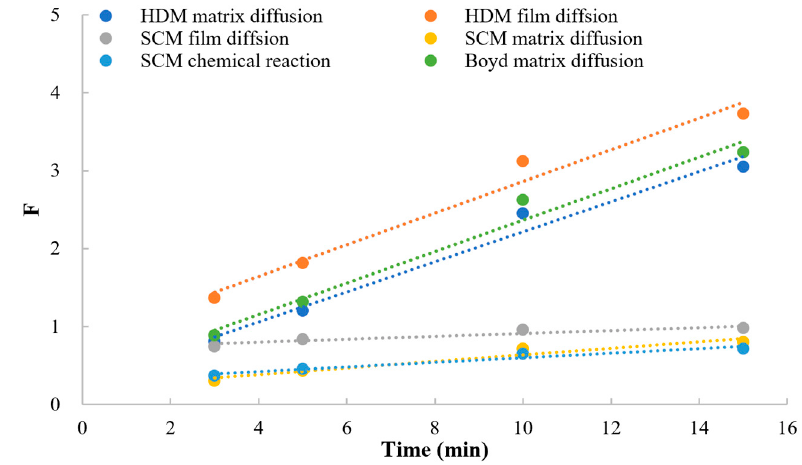
Figure 8. The linear regression analysis for HDM, SCM, and Boyd.